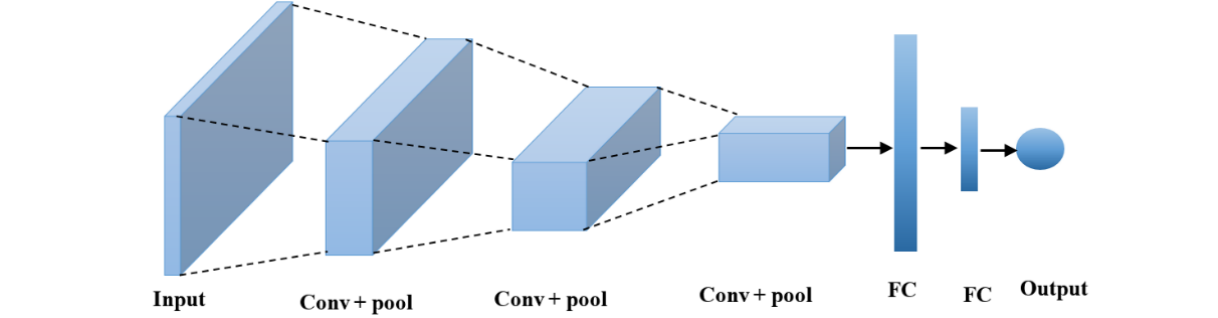
Figure 9. Structure of convolutional neural network with 3 convolution and pooling (conv+pool) layers and 2 fully connected (FC) layers.